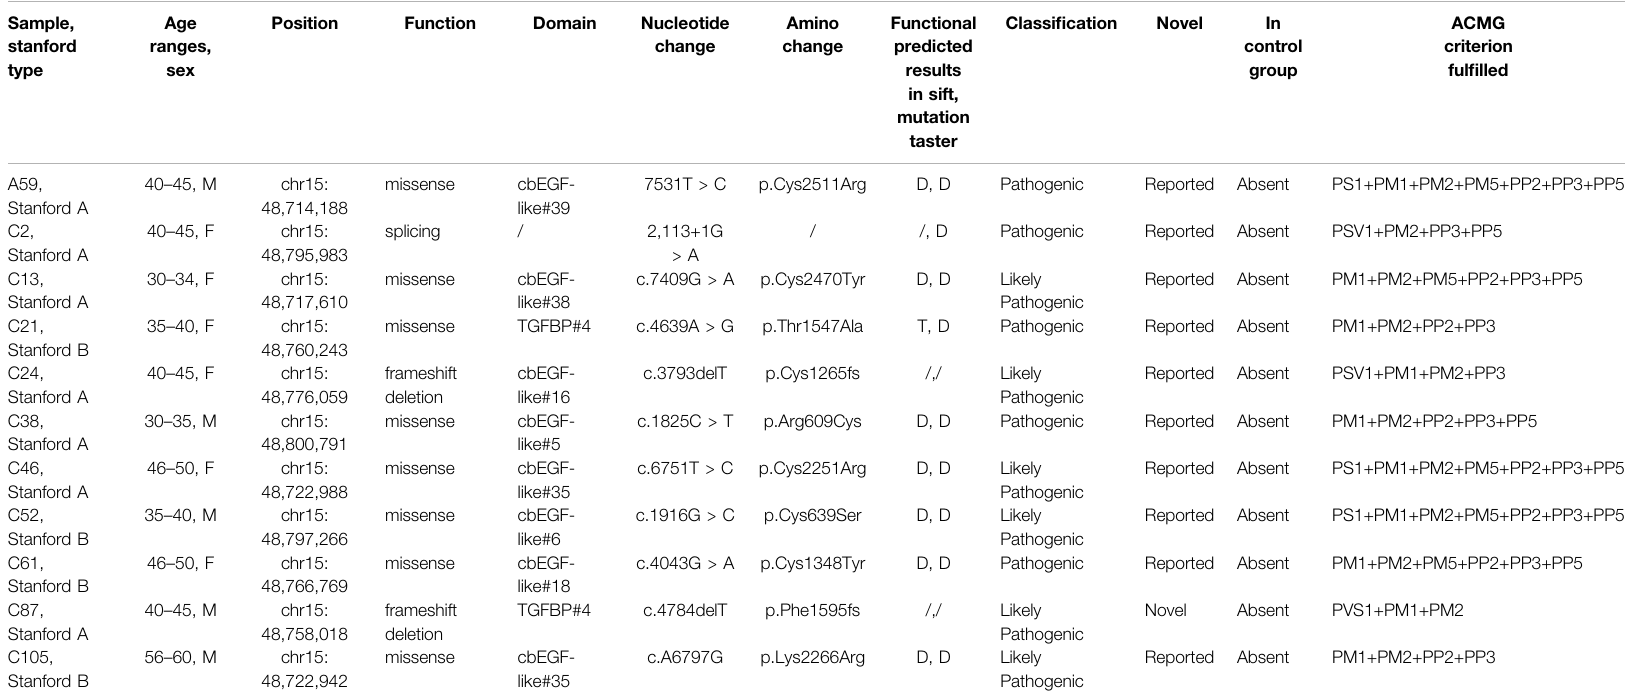
TABLE 2 | Detailed genetic and clinical information of AD patients harboring positive variants in FBN1. Sample,